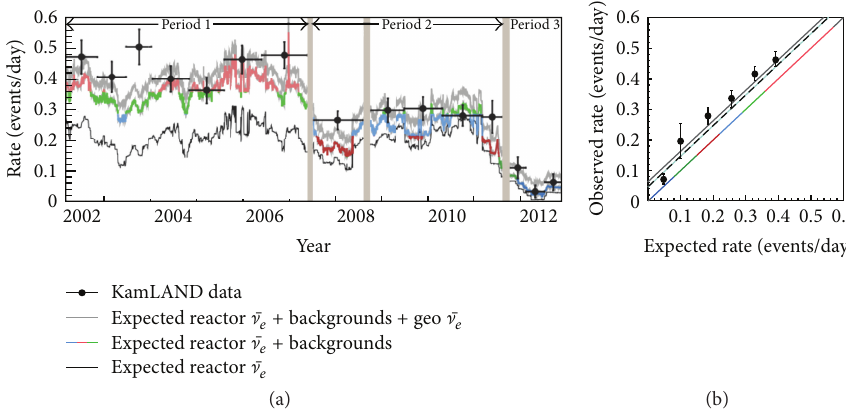
Figure 6: (a) Event rate in the KamLAND detector as a function of time in the 0.9–2.6 energy window. (b) The excess of events with respect to the expected background rate is constant in time and attributed to the geo- ] signal, taken from [51].